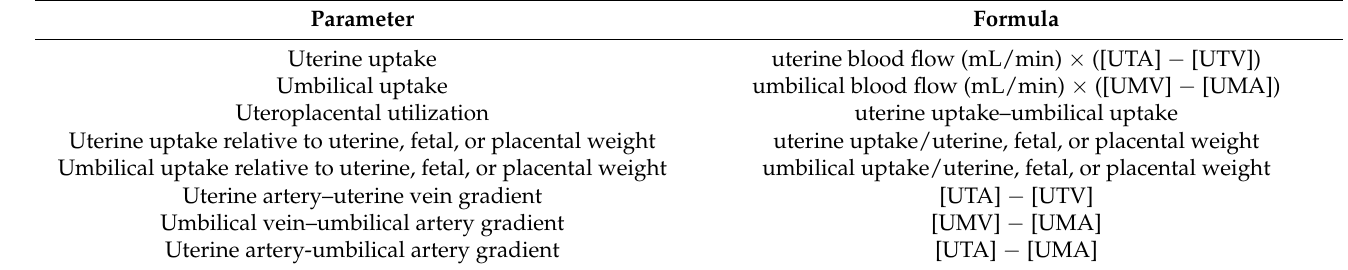
Table 4. Calculations for Nutrient Uptake and Utilization. Abbreviations: UTA = uterine